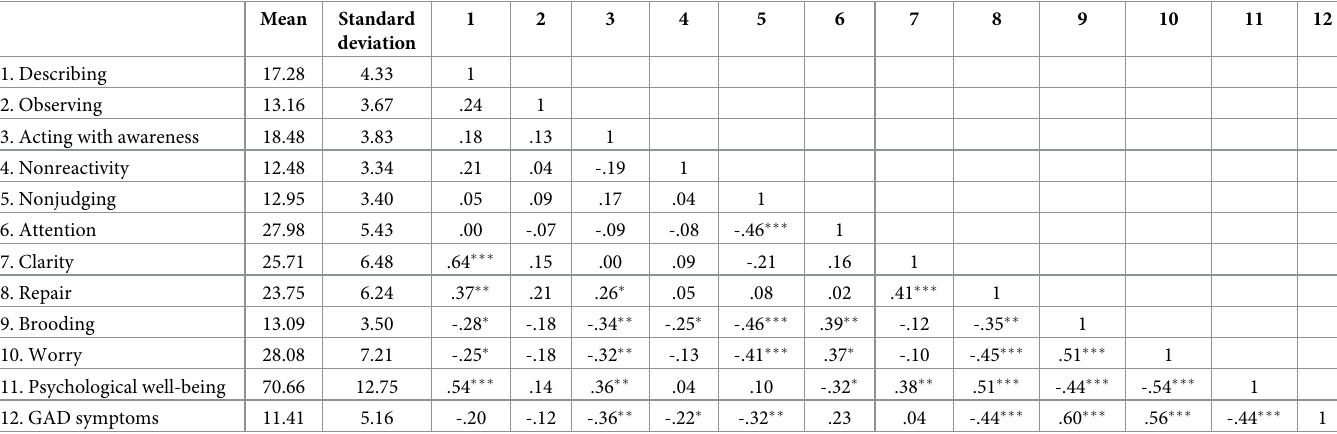
Table 1. Relationships between variables.